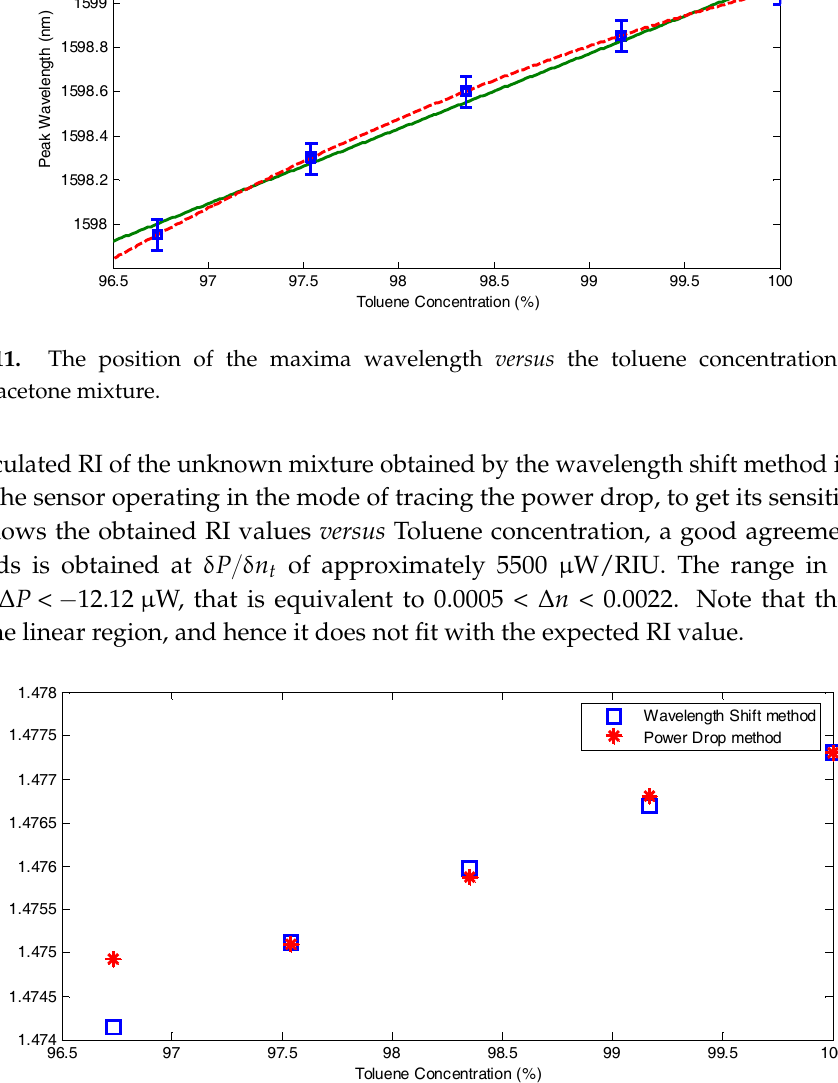
Figure 10. Zooming of the output power in μ W versus wavelength in nm around the selected peak for refractometry analysis.